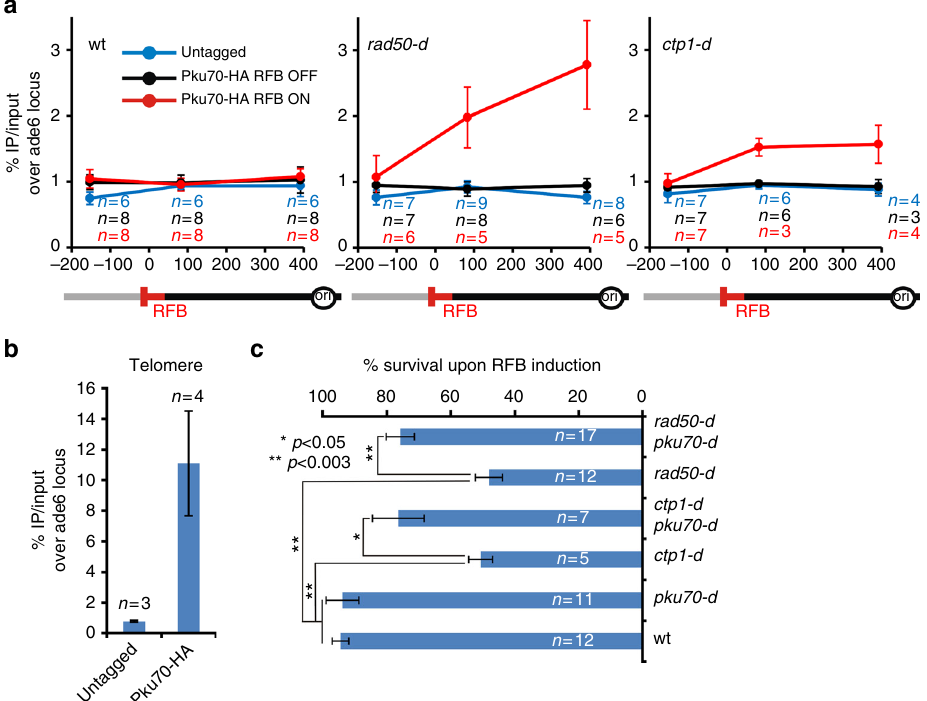
Fig. 4 MRN-Ctp1 allow Ku eviction from terminally arrested forks. a Analysis of Ku recruitment to the RTS1 -RFB by ChIP-qPCR in indicated strains and conditions. Upstream and downstream distances from the RFB are indicated in base pairs (bp). Values are means of n samples from independent biological replicates ± SEM. Statistical analysis was performed using the non-parametric Mann-Whitney U test. b Analysis of Ku recruitment to telomeres in wt strain. Values are means of n samples from independent biological replicates ± SD. c Survival of the indicated strains upon activation of the barrier relative to OFF condition. Values are means of n samples from independent biological replicates ± SEM. Statistics were calculated using the non-parametric Mann-Whitney U test. See Supplementary Fig. 3 for the analysis of cell sensitivity to CPT and